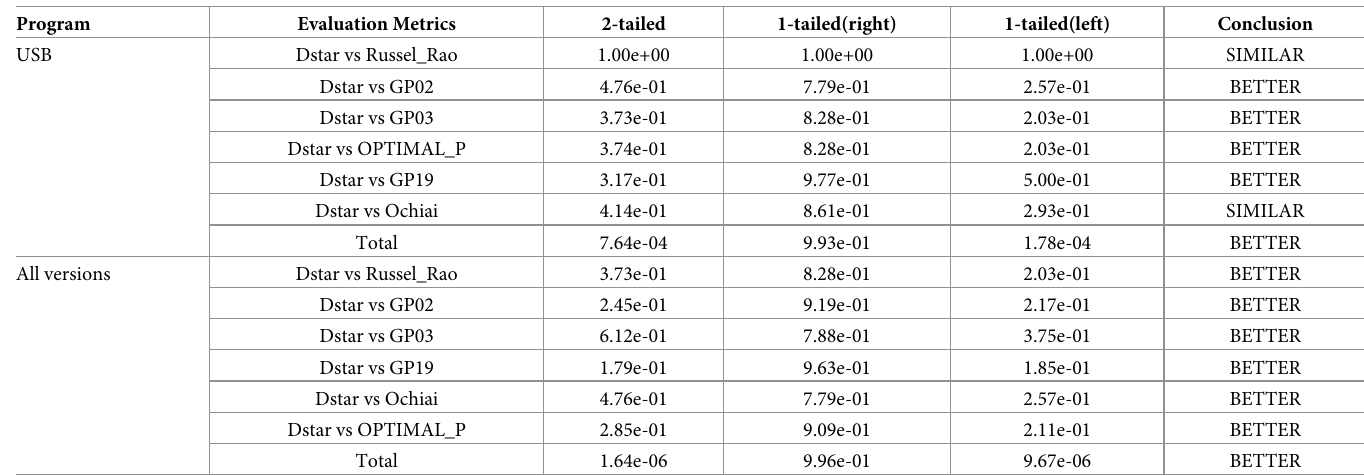
Table notes Phasellus venenatis, tortor nec vestibulum mattis, massa tortor interdum felis, nec pellentesque metus tortor nec nisl. Ut ornare mauris tellus, vel dapibus arcu suscipit sed.